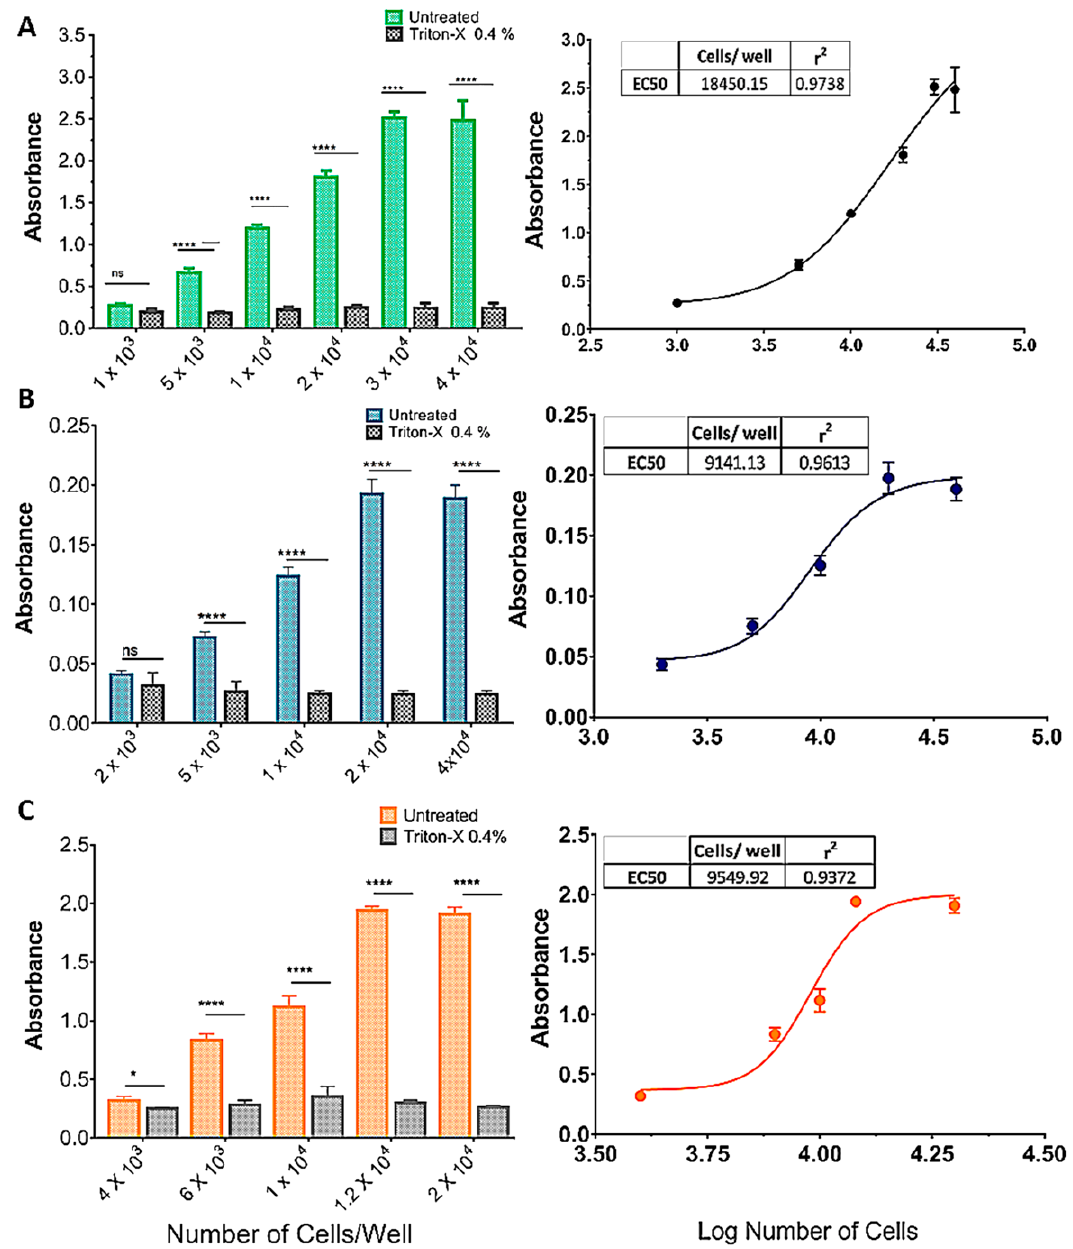
Figure 2. Standardization of the cell inoculum for the MTT reduction assay. ( A ) SHSY5Y, (B) U87, and ( C ) GL261 cell lines. The graphics show the effect of increasing cell densities on OD 570 in an MTT protocol with or without incubation with Triton X-100 (0.4%). As cell density increased, so did the difference between treatments, in an S-shaped curve ( A – C ). For the SHSY5Y ( A ) and U87 ( B ) cell lines, there was no difference between treatments ( p > 0.001) at the lowest densities (1 × 10 3 and 2 × 10 3 , respectively), whereas for the GL261 cell line, Triton yielded a significantly higher absorbance at 4 × 10 3 cells/well. The effect of cell density was saturated for the SHSY5Y, U87, and GL261 cell lines at 3 × 10 4 , 2 × 10 4 , and 1.2 × 10 4 cells/well, respectively ( A – C ). Data are expressed as mean ± standard deviation. To test the homogeneity of variance, we used Bartlett’s test. For the statistical comparison of the data, we used two-way ANOVA followed by Sidak’s post-test ( p < 0.001), ns = not significant, (* = p < 0.05; **** = p < 0.001). Graphs represent three independent experiments performed in triplicate.